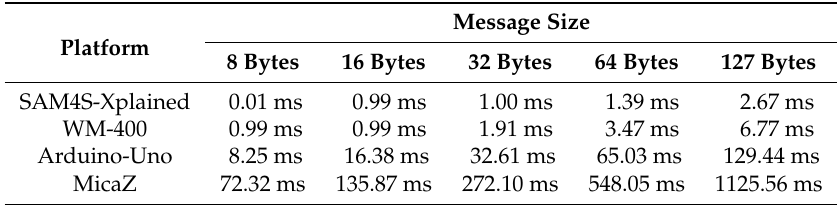
Table 5. Encode times of different